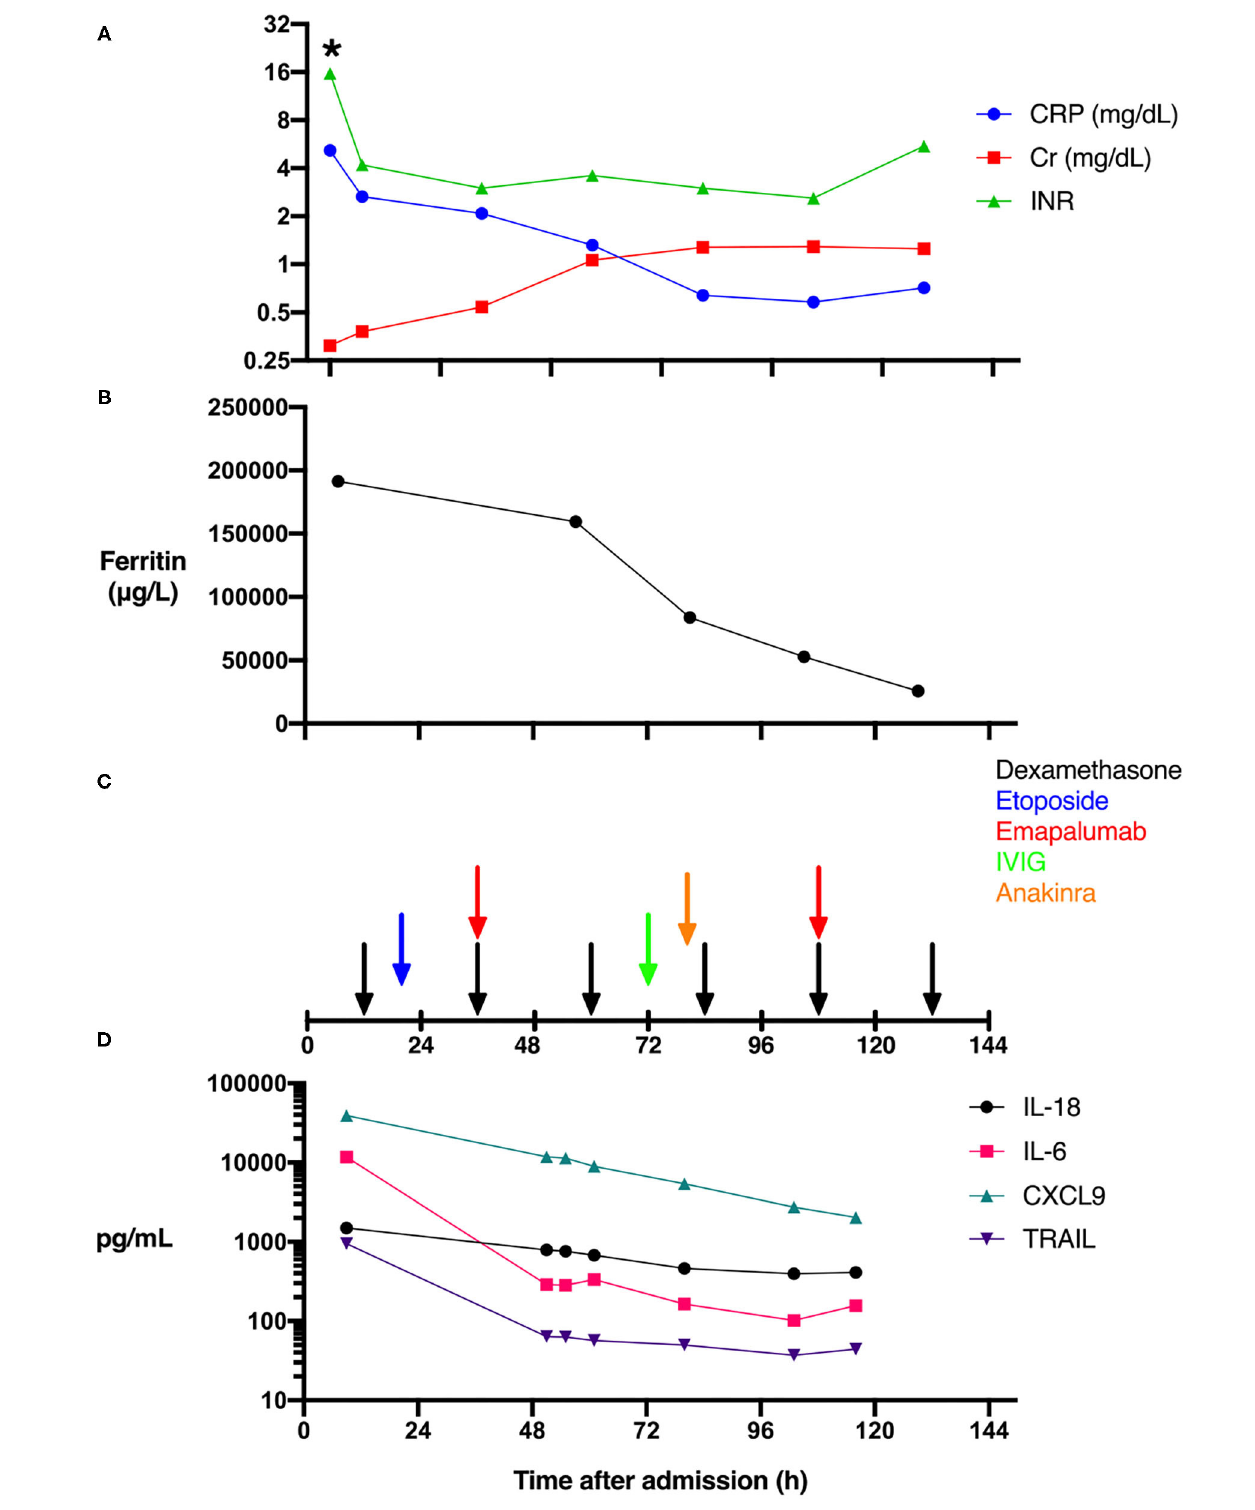
FIGURE 1 | Effect of immune modulation on biomarkers, organ dysfunction, and cytokine levels during HSV-associated secondary HLH. The time course of clinical laboratory values of serum C-reactive protein (CRP), creatinine (Cr), and INR levels (A) , ferritin levels (B) , as well as the timing of the administration of the immune suppressive agents is shown (C) . While IL-6 and TRAIL levels fell precipitously after admission, CXCL9 and IL-18 levels fell more gradually (D) (*Actual INR resulted as > 15.7).